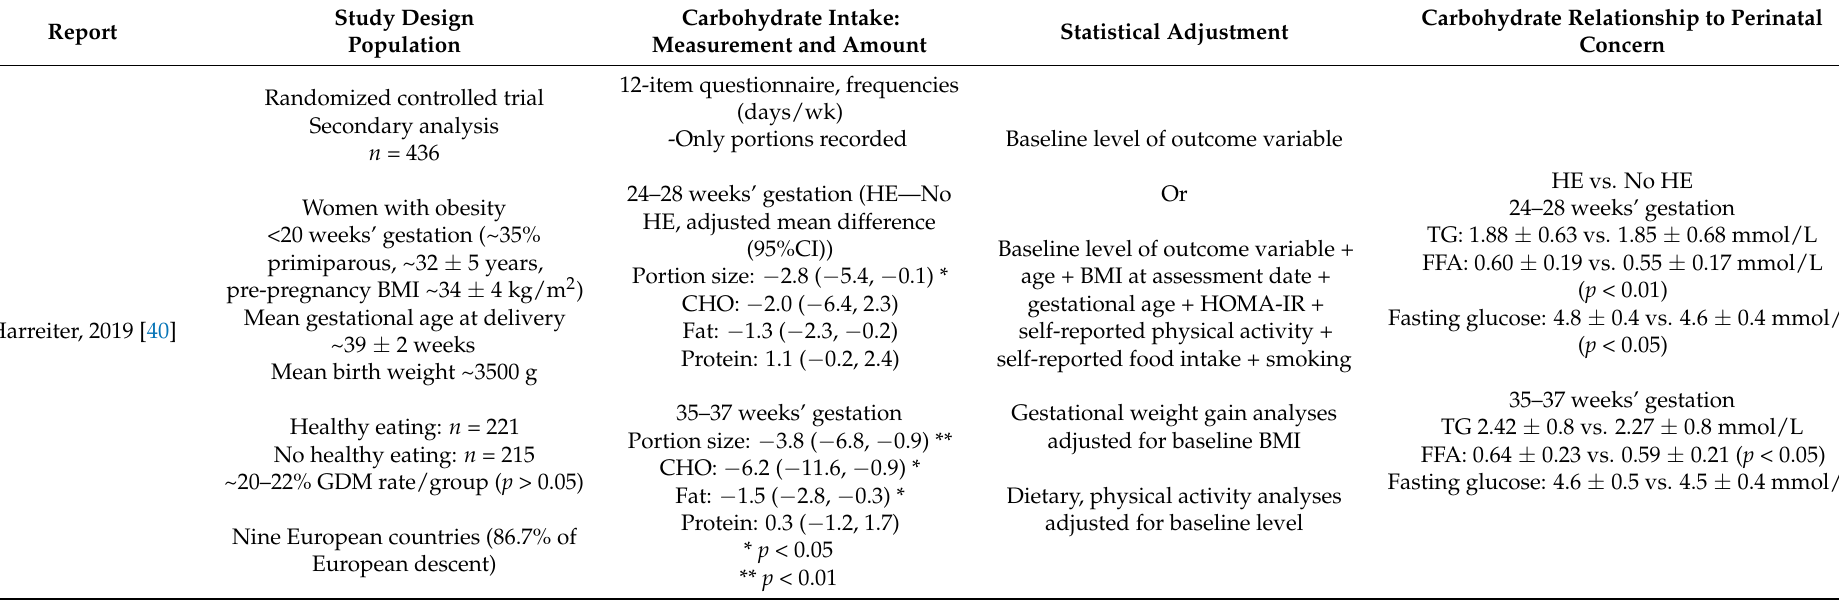
Table 4. Reports relevant to research question 4: Do pregnant women who consume a LC diet have higher TG or FFA, increasing fetal exposure to